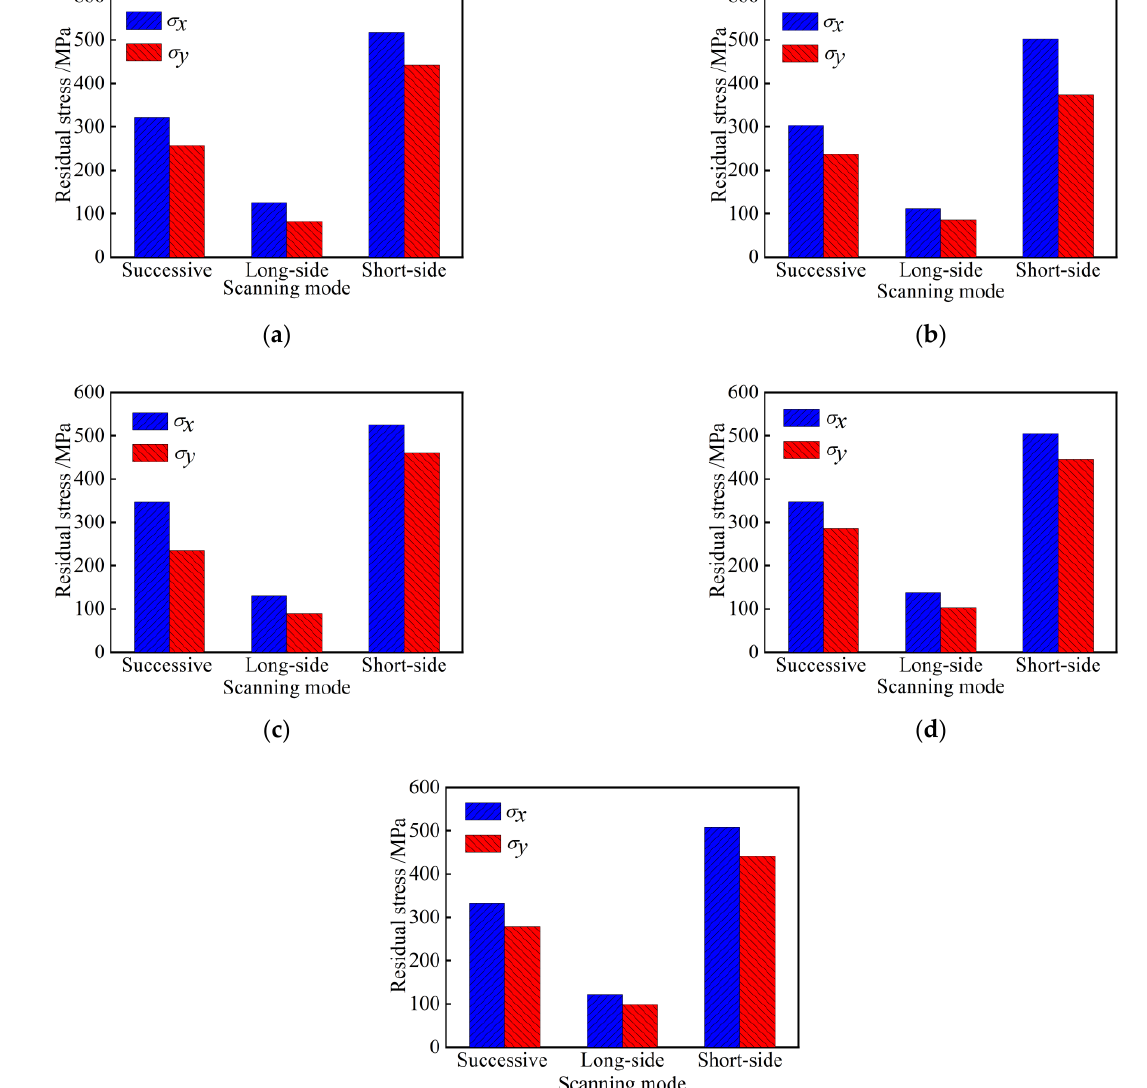
Figure 14. Residual stress at different scanning modes ( a ) Test point A; ( b ) Test point B; ( c ) Test point C; ( d ) Test point D; ( e ) Test point E.